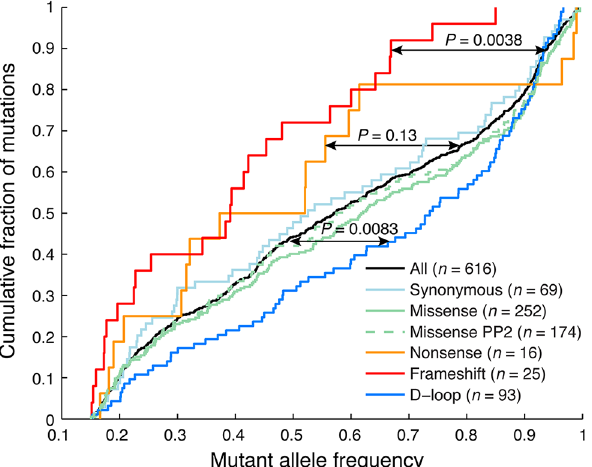
Fig 2. Frameshift indels show reduced heteroplasmy levels indicative of negative selection. Cumulative distributions of mutant allele frequencies (heteroplasmy levels) for different mutational categories. Frameshift indels showed significantly reduced levels of heteroplasmy, and never reach above 85%. A similar trend, although non-significant, was seen for missense (stop-inducing) mutations. In contrast, D-loop mutations, which in general should be more tolerable, showed significantly elevated levels. P -values were calculated using the two-sample Kolmogorov-Smirnov test, comparing the tumor set of interest to remaining samples. Missense PP2 refers to a subset of missense mutations predicted to be “ probably damaging ” by PolyPhen-2